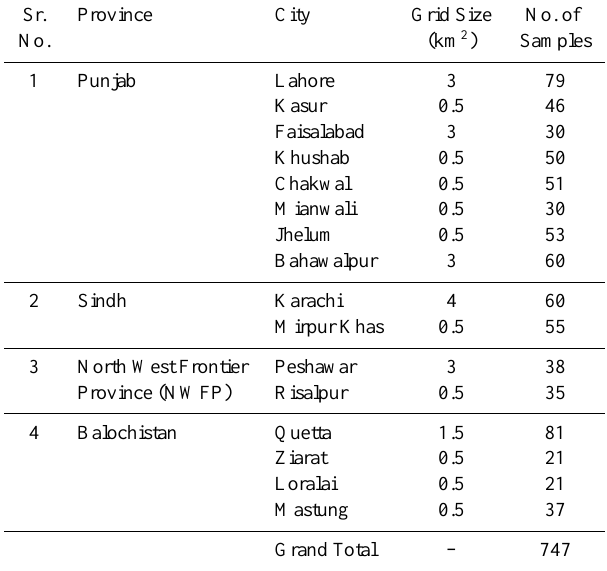
Table 1. Sampling criteria and no. of samples collected from four provinces of